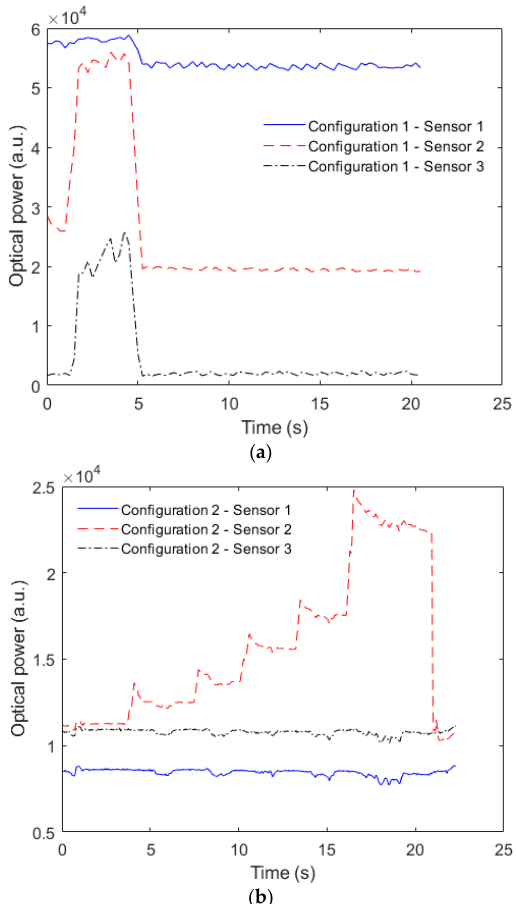
Figure 6. Optical power transmission as a function of time for sensors 1, 2 and 3 considering ( a ) Configuration 1 and ( b ) Configuration 2 .